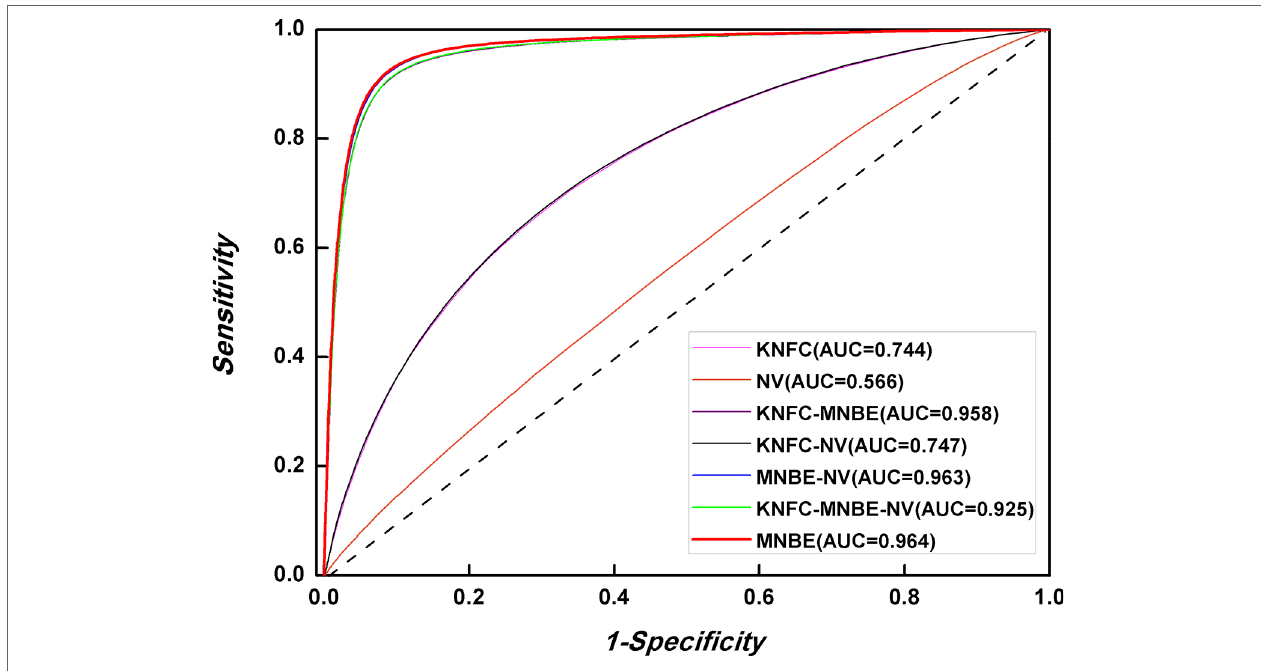
FIGURE 4 | Performance evaluation based on three features and their